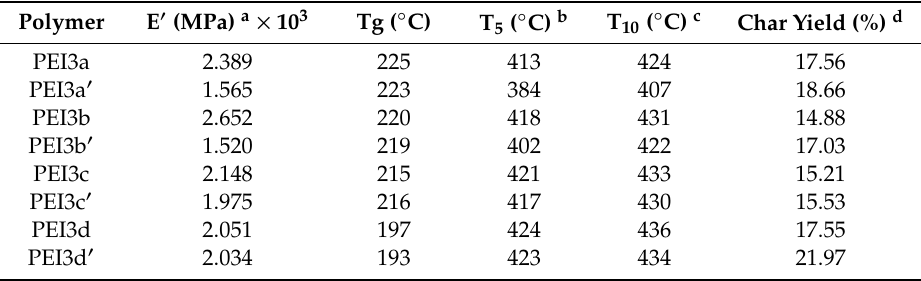
Table 3. Thermal properties of PEI3a–PEI3d ′ .